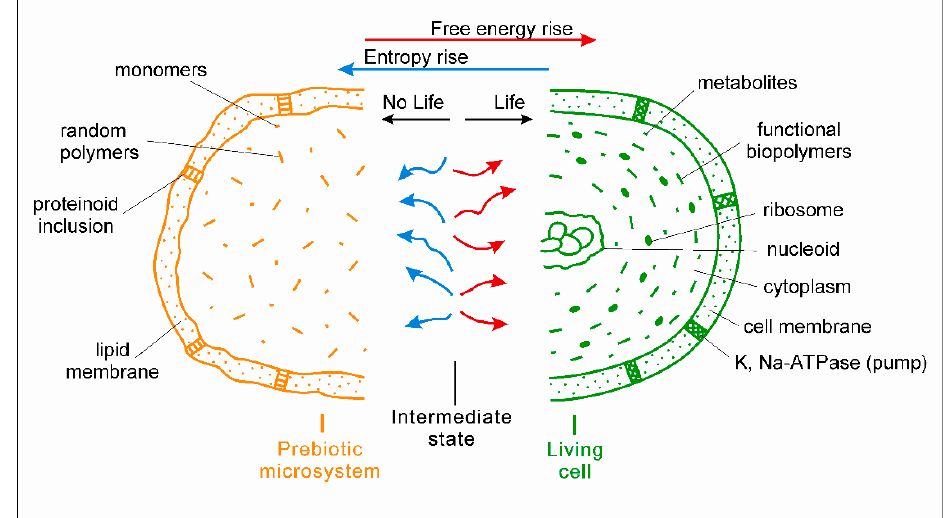
Figure 2. The intermediate state between ‘non-life’ and life. Left , yellow—non-living prebiotic microsystem (half) composed of random polymers, monomers, and simple molecules. Center : thermodynamically intermediate state between non-life and life, relative equality of the contributions of chemical reactions producing free energy (red) and entropy (blue). Right , green—primary living microorganism (half). Its advanced version is shown—a modern prokaryotic cell with the main cellular structures: nucleoid (ring DNA), ribosomes, and cell membrane.